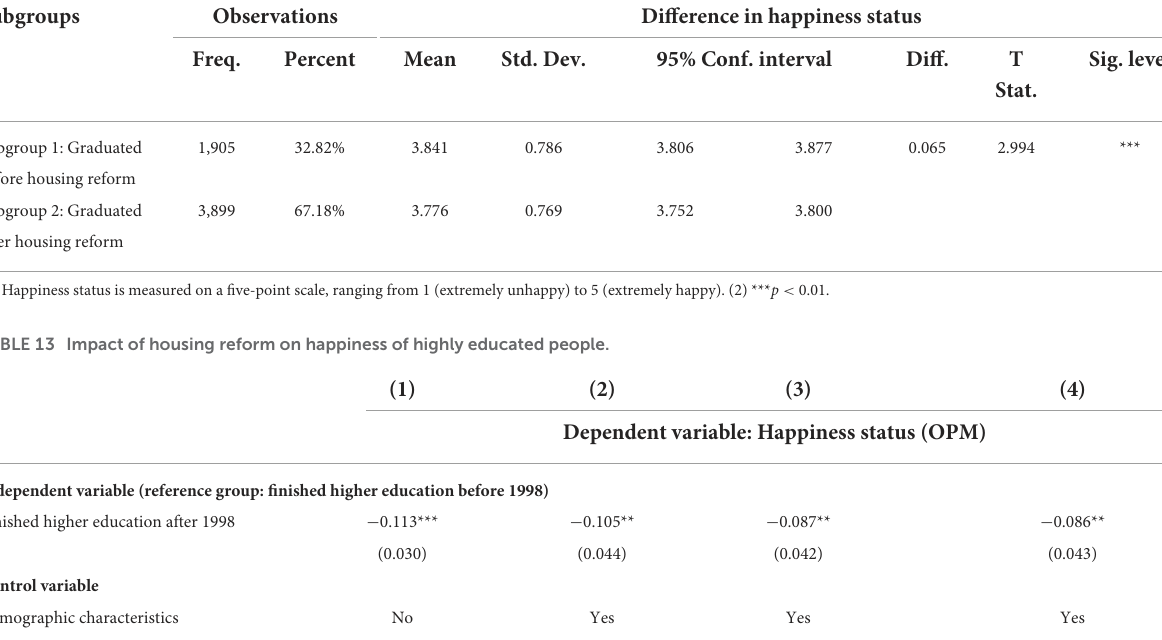
TABLE 12 Difference in happiness of highly educated people in two subgroups.